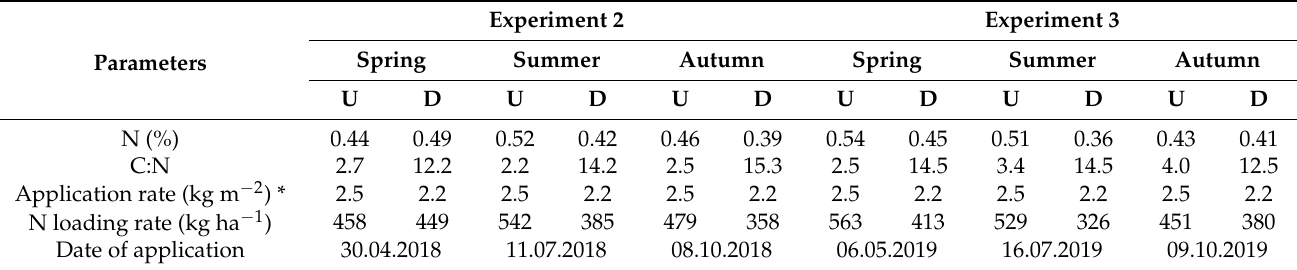
Table 2. Cow excreta chemical characteristics and application